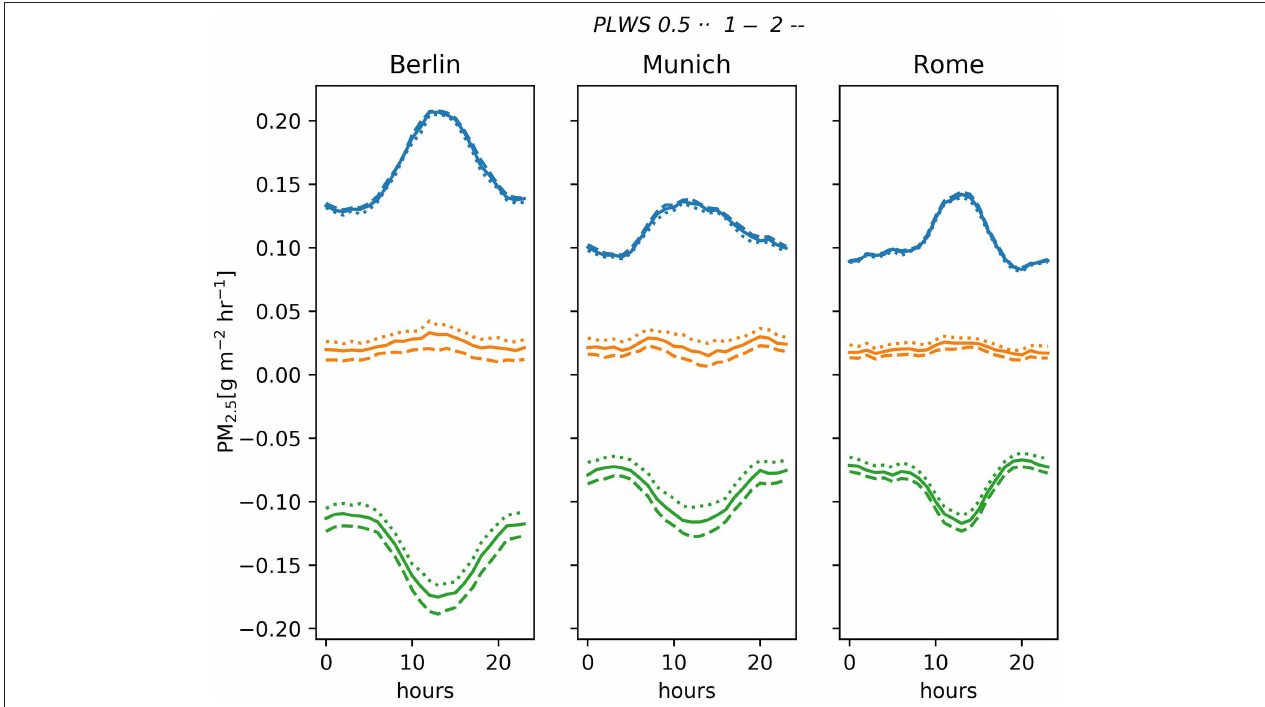
FIGURE 5 | Sensitivity of deposition (blue lines), net removal (orange), and resuspension (green) to parameter changes of potential leaf water storage (plws) shown for three different sites. All simulations are carried out for the period of 2013 and presented as the average diurnal